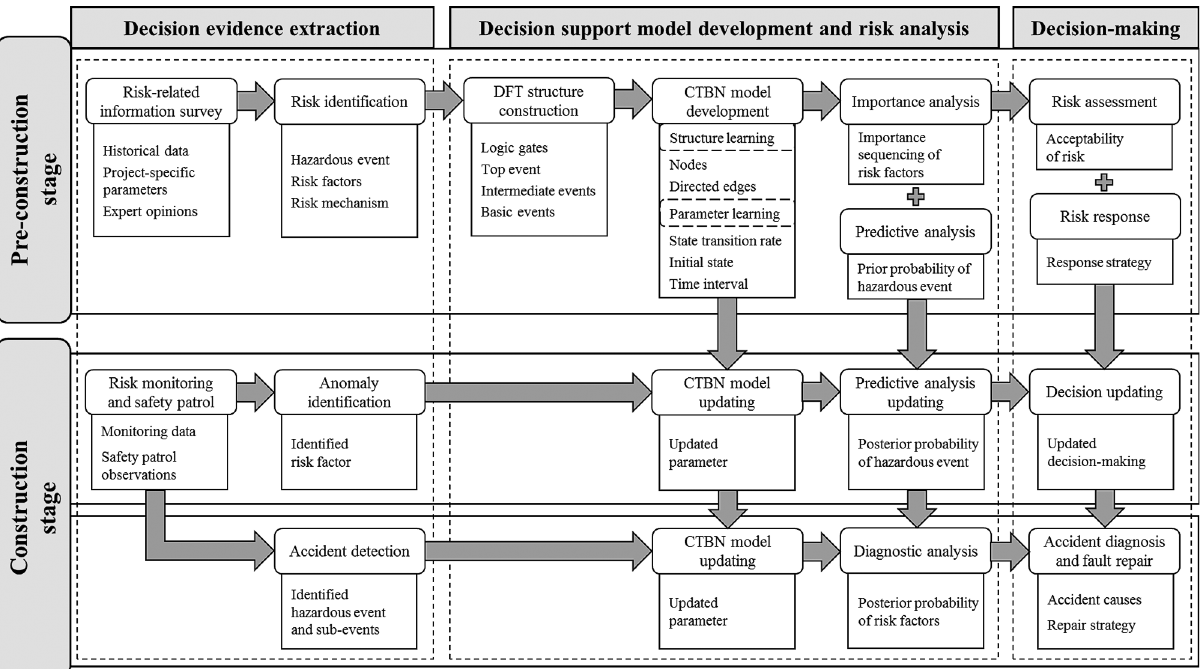
Figure 7. Flow chart of the proposed dynamic risk decision support approach for metro tunnel